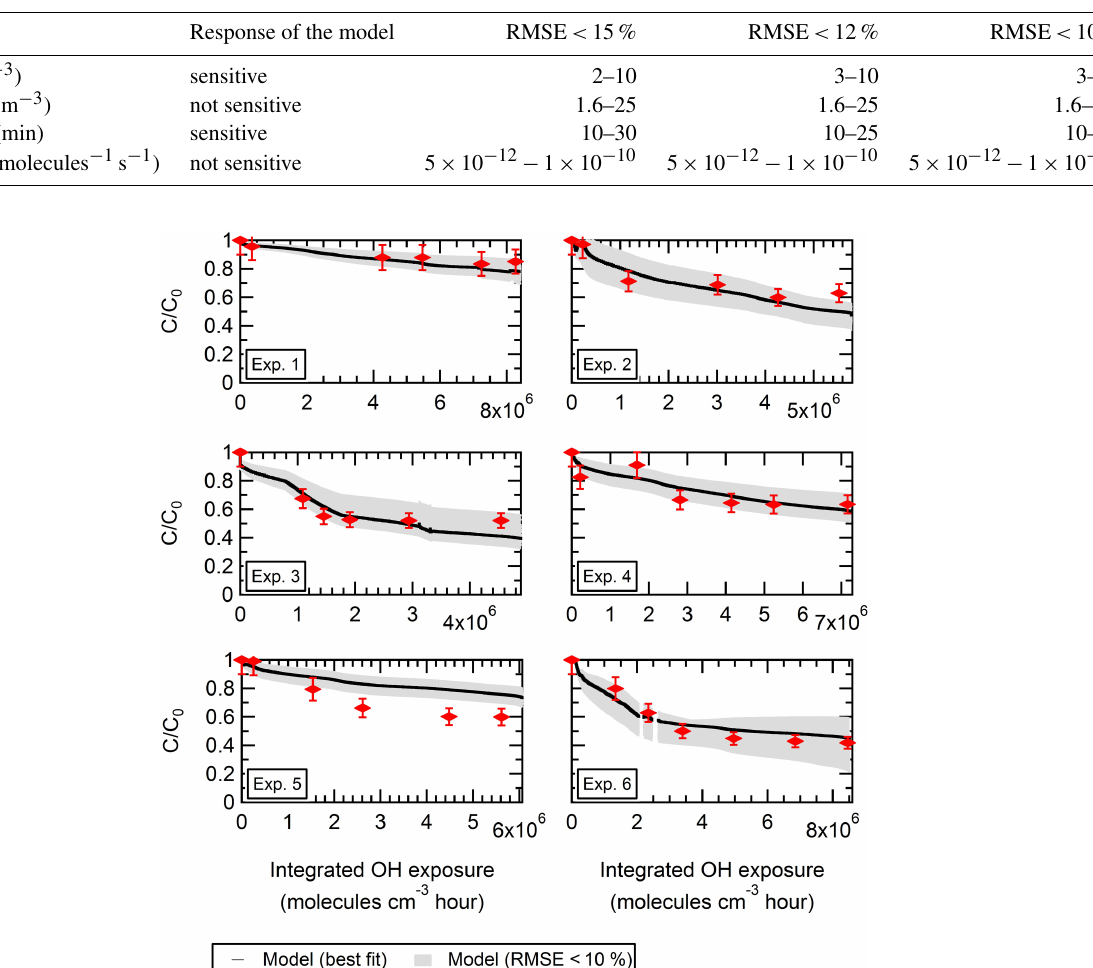
Table 3. Performance of the model for levoglucosan (iteration 2). Initial conditions for this run are presented in Table 2. The accommodation coefficient was set at 0.1. Best fit of the model data with the experimental measurements revealed a RMSE of 7.63%.